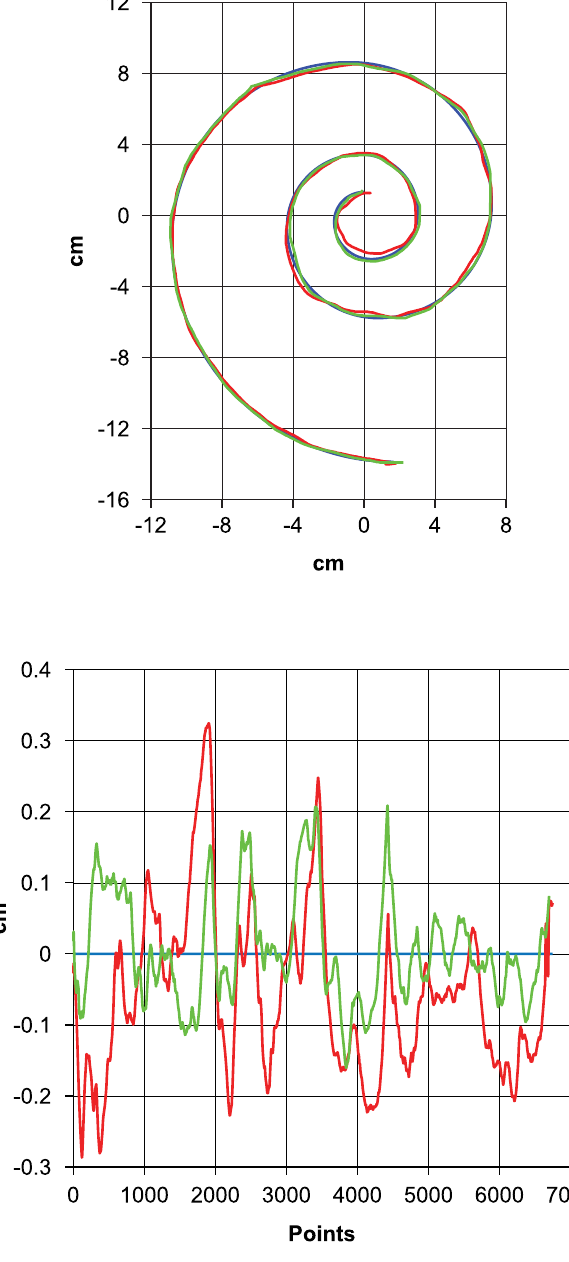
Figure 3. Spiral analysis. An example of how the spirals were analyzed. In the upper panel, it is possible to see three spirals that correspond to the template (blue), tracing in the Before trial (red), and tracing in the After trial (green). It should be noted that the first tracing was not visible to the participant during the second tracing. In the bottom panel it is possible to see the differences between the tracings more clearly, with the template corresponding to zero, and the tracings as deviations from the template. In this example it is possible to see an improvement in the After trial (green) compared to the Before trial (red). The participant in this case was part of the Fidget group, with a mean RD of 0.13 cm and a total area of deviation of 3.14 cm 2 in the Before trial and 0.09 cm and 2.19 cm 2 in the After